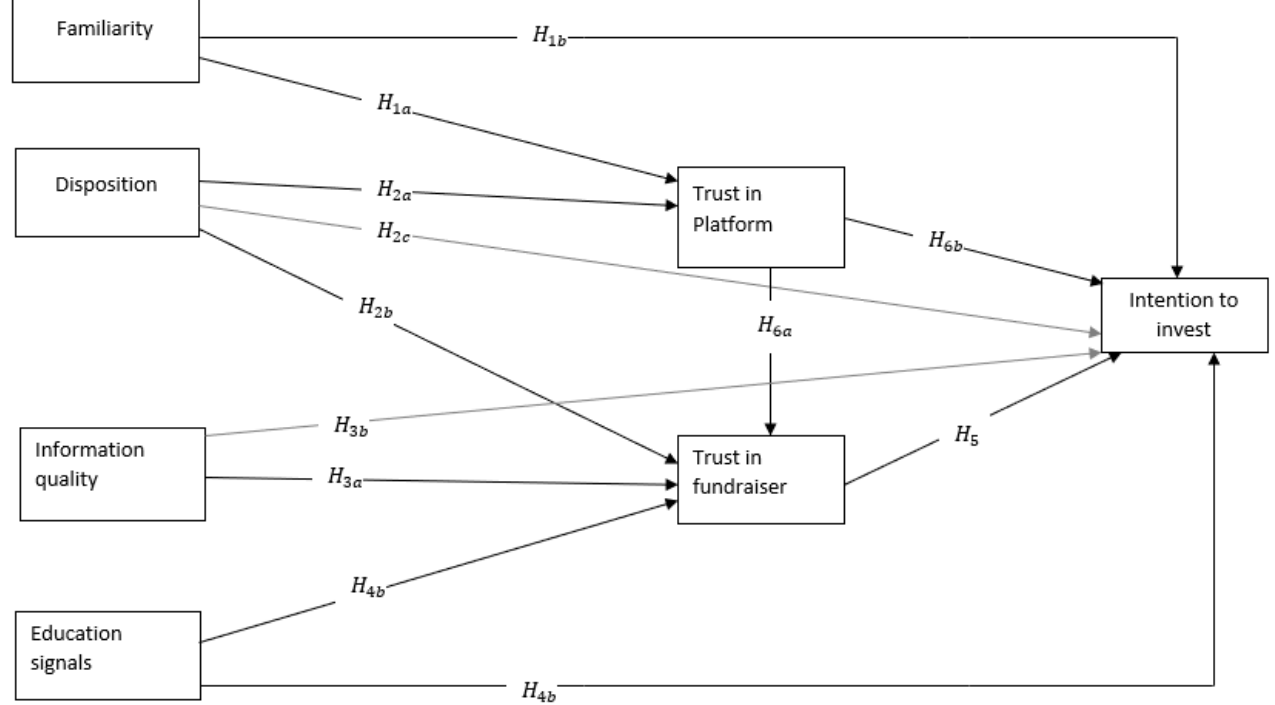
Figure 1. Proposed Figure 1. Proposed model.